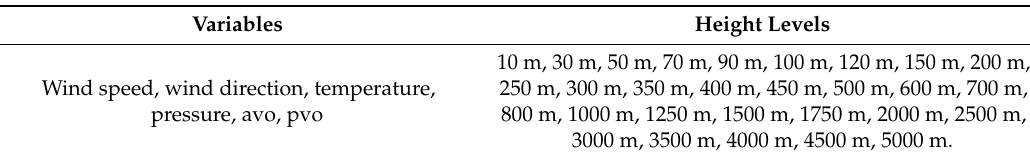
Table 4. GBDT input features at di ff erent height layers.